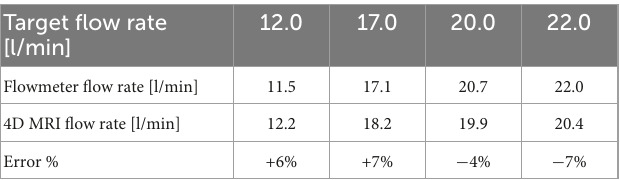
TABLE 5 Average continuous antegrade flow rates from the flowmeter and 4D